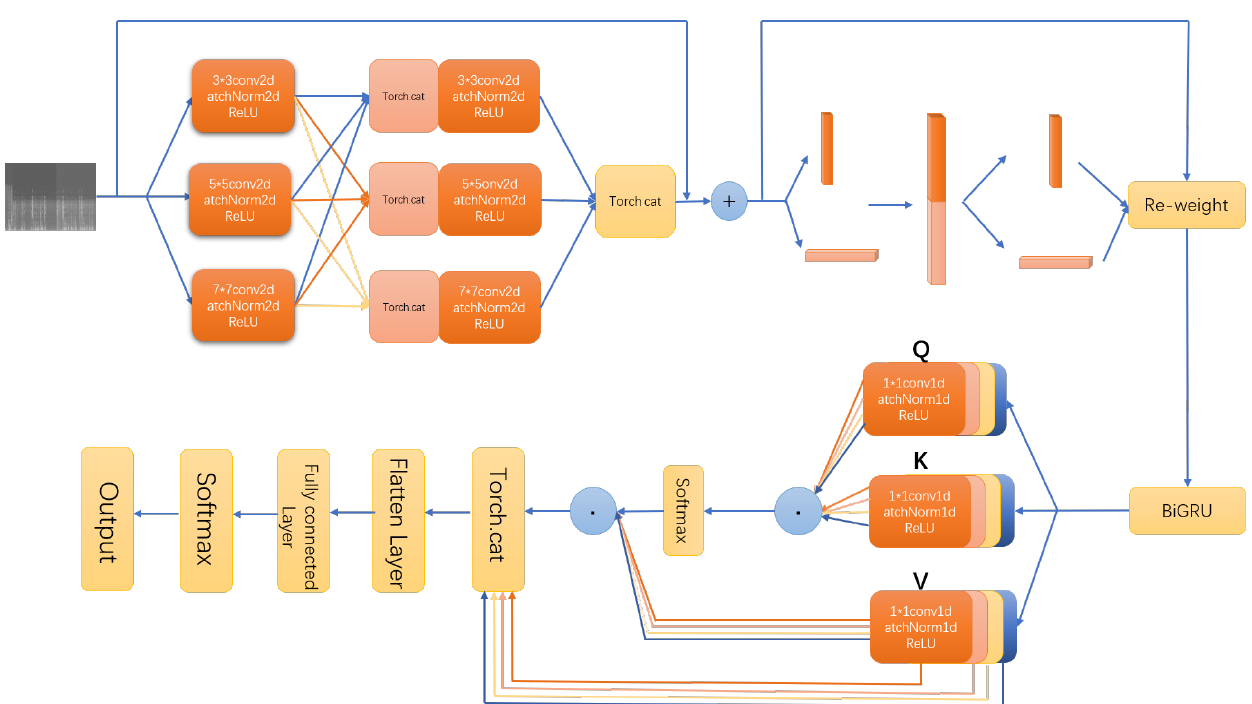
Figure 1. Diagram of the overall structure of the network. (The MSRN module is on the top left, the coordination attention module is on the top right, and the MHSA module is on the bottom right).